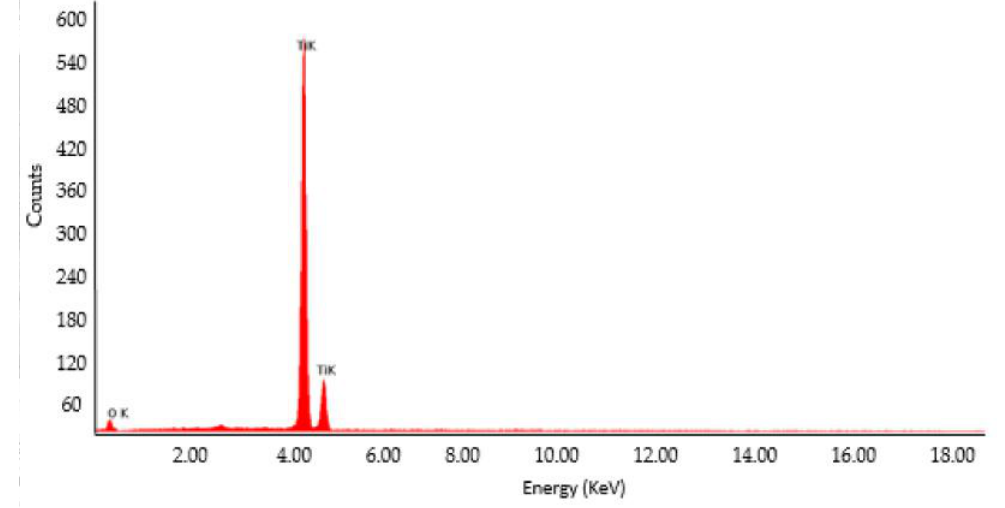
Figure 16. EDS spectra showing Ti and O specific